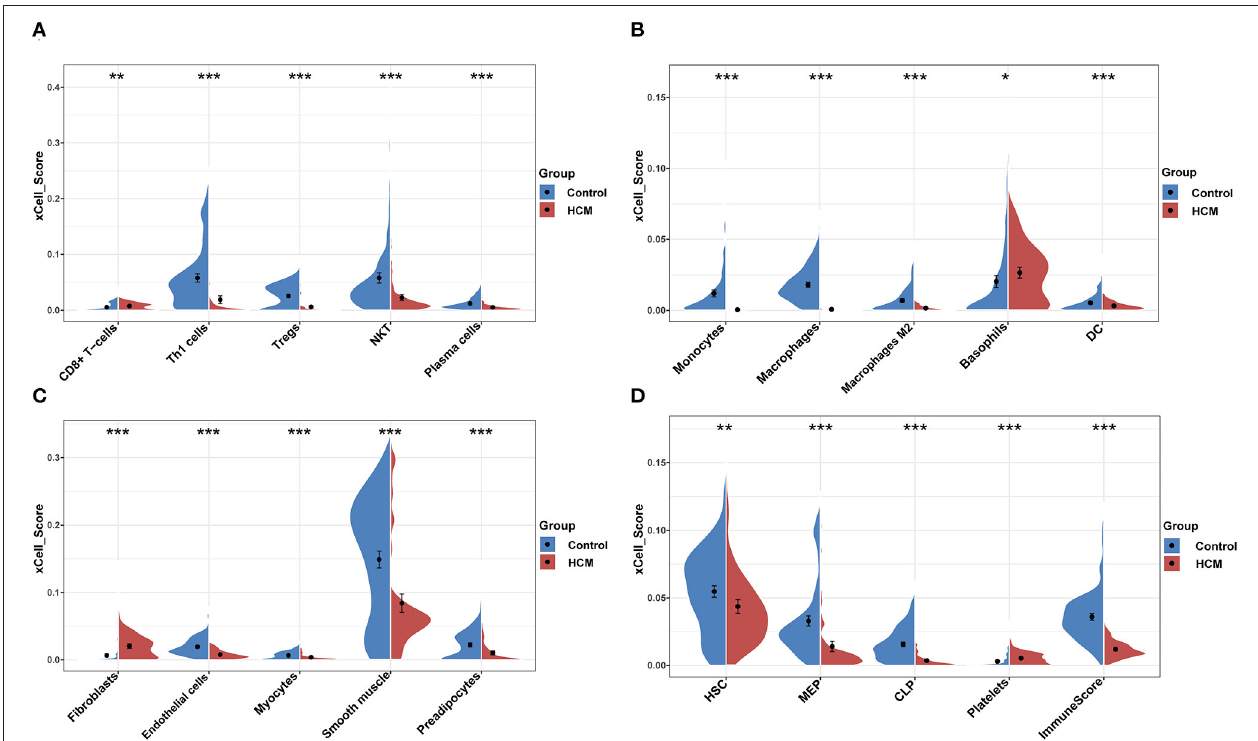
FIGURE 4 | xCell scores of immune or stromal cells between HCM and healthy control cardiac tissues in GSE36961 and GSE141910. (A–D) Violin charts of “lymphoid cells,” “myeloid cells,” “stromal cells,” and “stem cells and others,” respectively. * p < 0.05, ** p < 0.01, *** p <